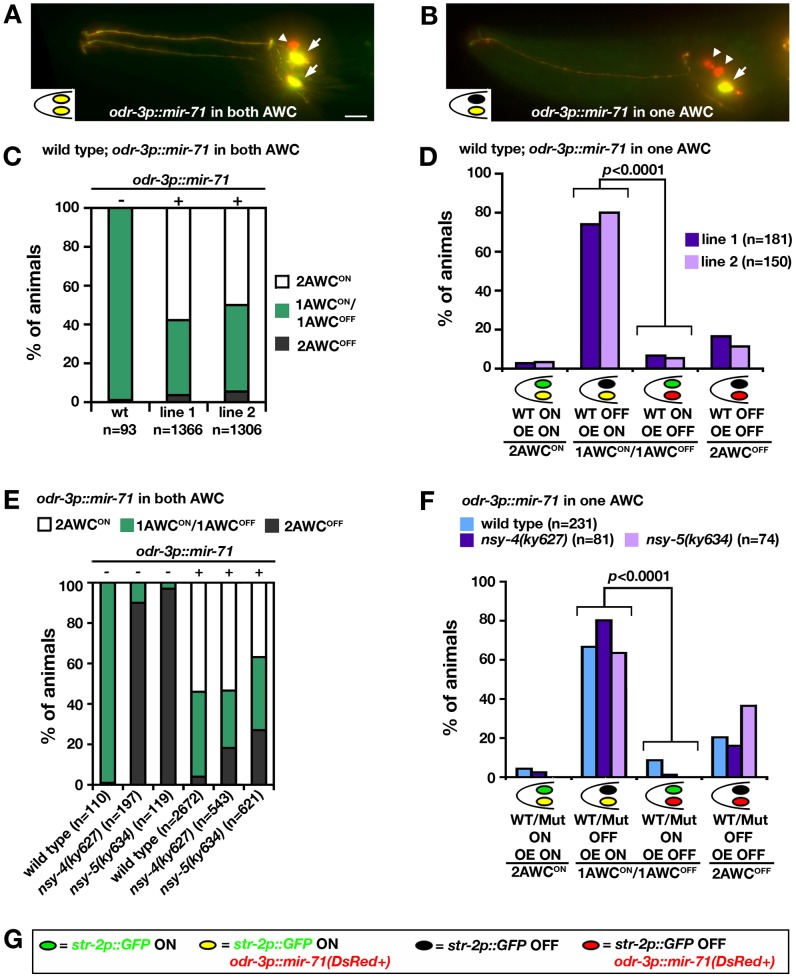

mir-71 acts cell-autonomously to promote AWCON.(A, B) Projections of wild-type animals expressing an integrated str-2p::GFP transgene (green) and an unstable transgenic array containing odr-3p::mir-71 and odr-1p::DsRed (red). AWC neurons with co-expression of GFP and DsRed appear yellow. Arrows, AWC cell body; arrowheads, AWB cell body; scale bar, 10 µm. (C, E) AWC phenotypes of wild type (C), nsy-4(ky627), and nsy-5(ky634) mutants (E) expressing the transgene odr-3p::mir-71; odr-1p::DsRed in both AWC neurons. + and − indicate the presence and absence of the transgene odr-3p::mir-71, respectively. (D, F) AWC phenotypes of wild-type (D) and mutant (F) mosaic animals expressing the transgene odr-3p::mir-71; odr-1p::DsRed in one AWC neuron. Two independent transgenic lines were analyzed in wild type, nsy-4(ky627), and nsy-5(ky634) mutants in (C–F). Results from two independent lines were similar and thus were combined in (E, F). Z-test was used to calculate p values. (G) Color codes for AWC neurons in (A), (B), (D), and (F).